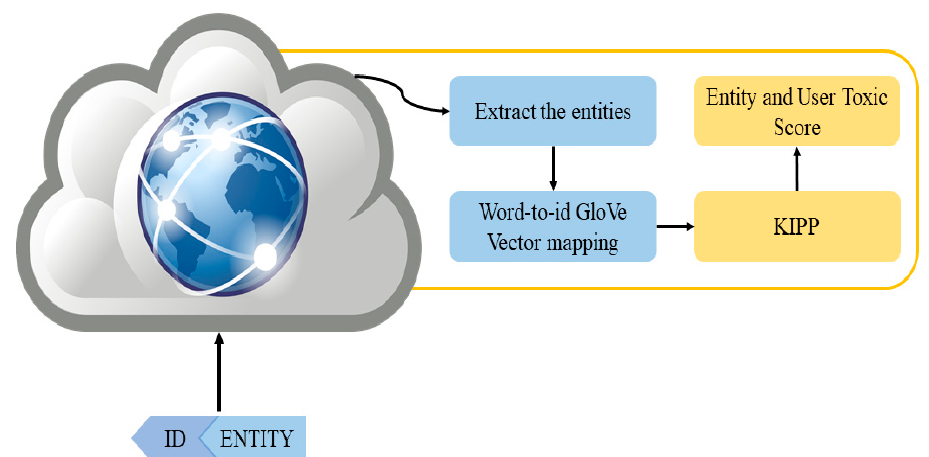
Figure 3. Cloud-level Module of MaLang.